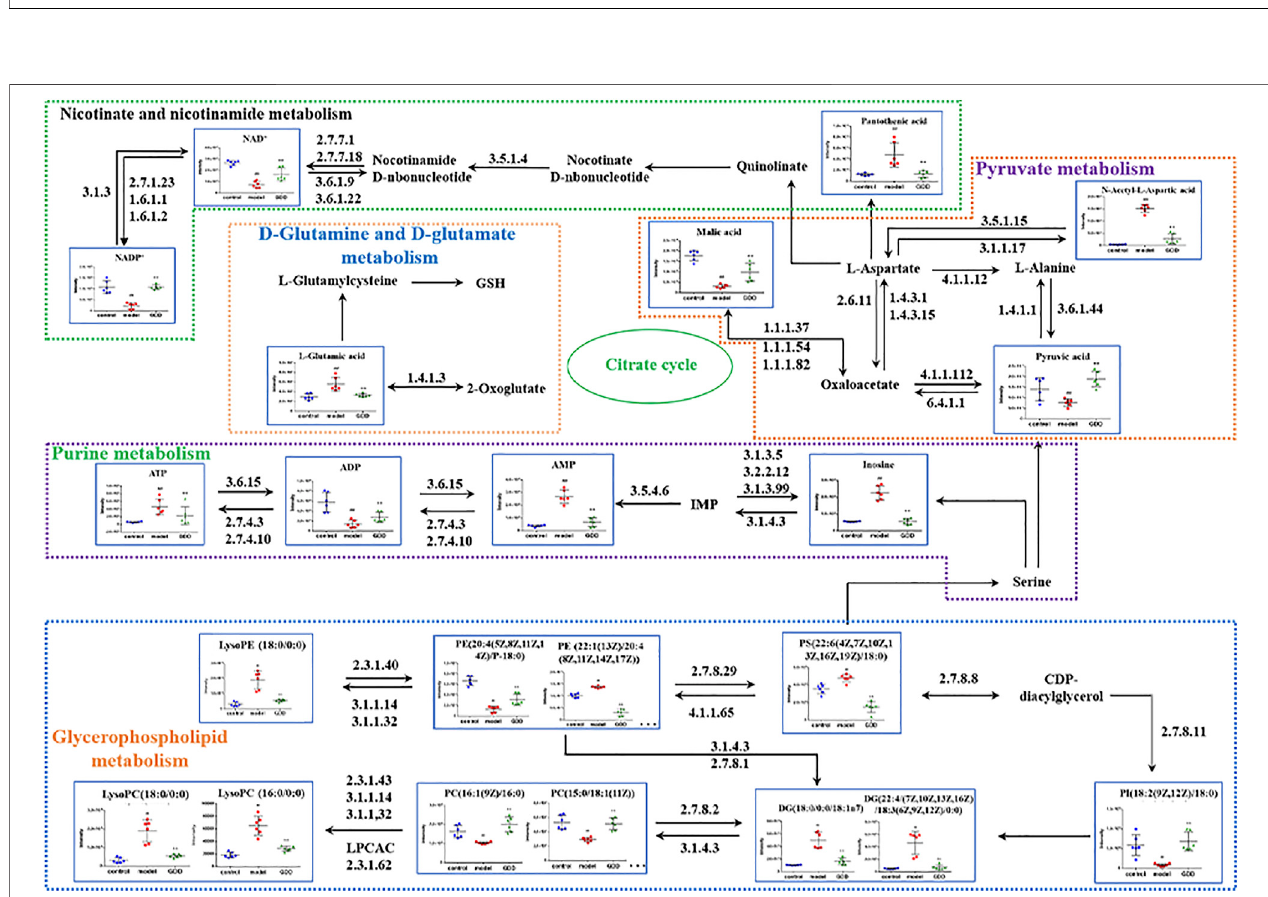
FIGURE 10 | Metabolic network diagram of potential biomarkers in copper-laden HLD hepatocytes by GDD.